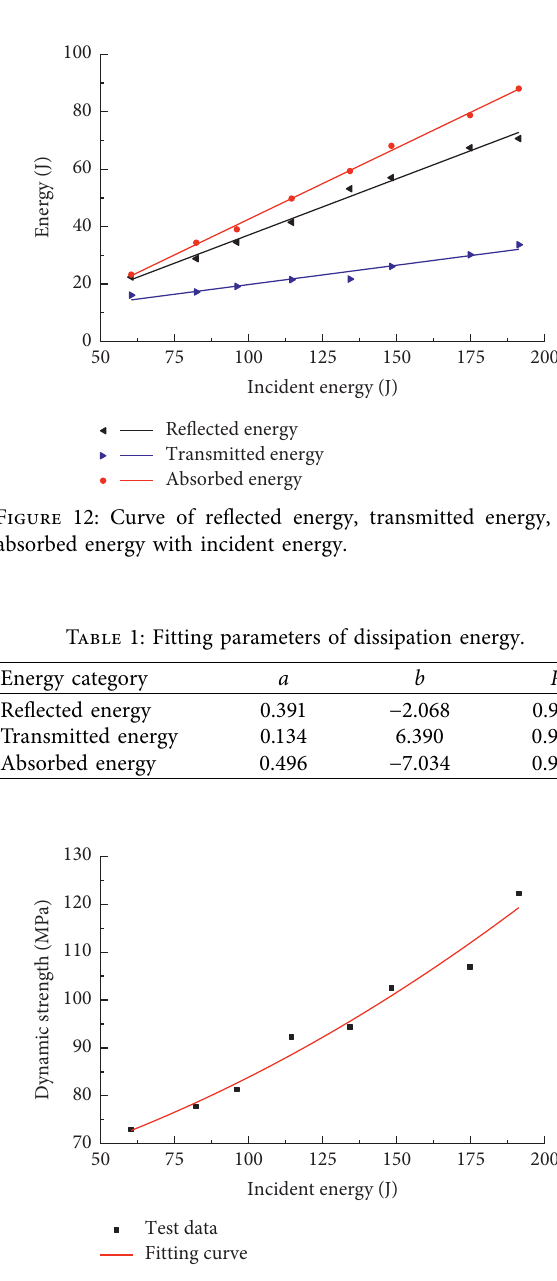
Figure 13: Relationship curve between dynamic strength and incident